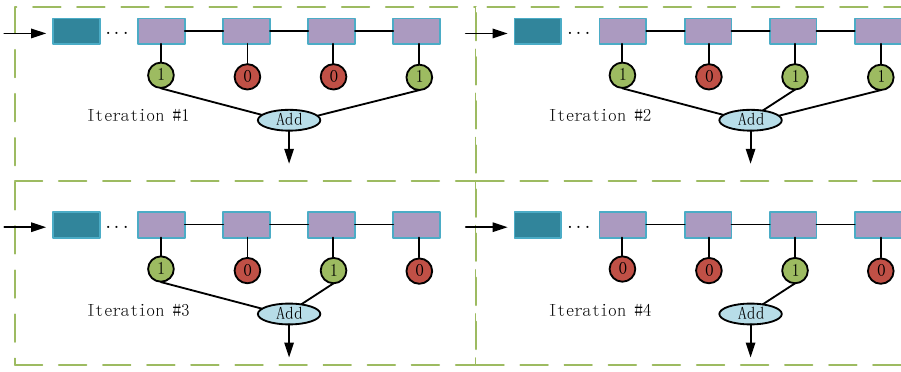
Figure 6. The stochastic decision-level fusion training strategy. The detailed backbones and classifiers are omitted. The blue and purple rectangles represent different stages. The green circles with ”1” indicate the classification scores that participate in the fusion process, while the red circles with ”0” do not